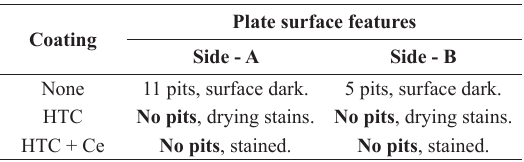
Table 8. Uncoated and coated plate surface features after 14 months exposure to the IEA-R1 reactor’s spent fuel